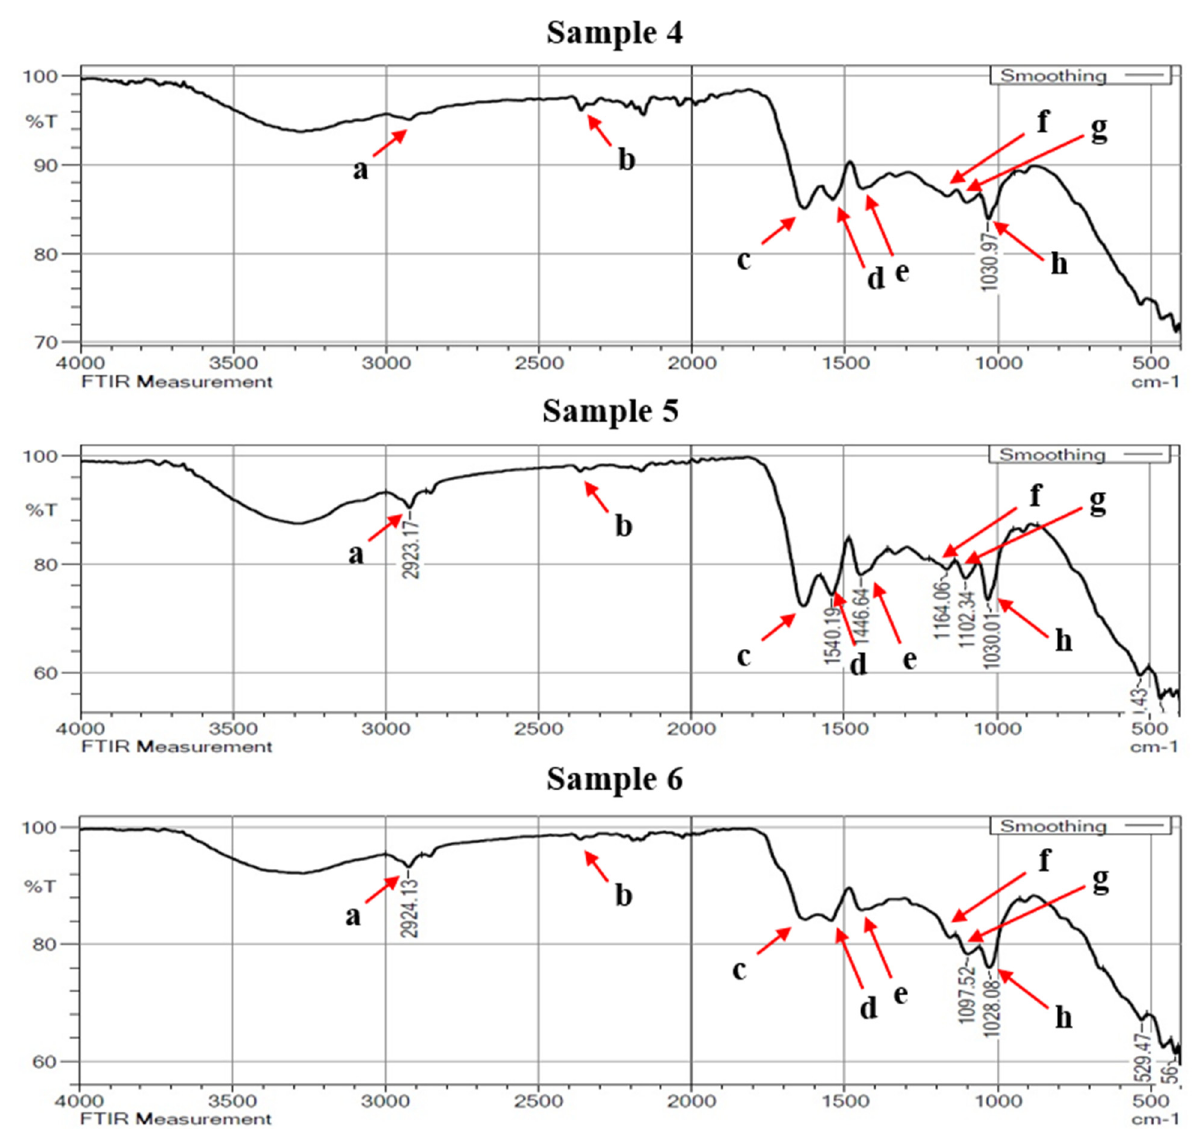
Figure 9. FTIR spectra of buffalo leather samples 4 to 6. Table 4. Functional groups and their quantified frequencies.